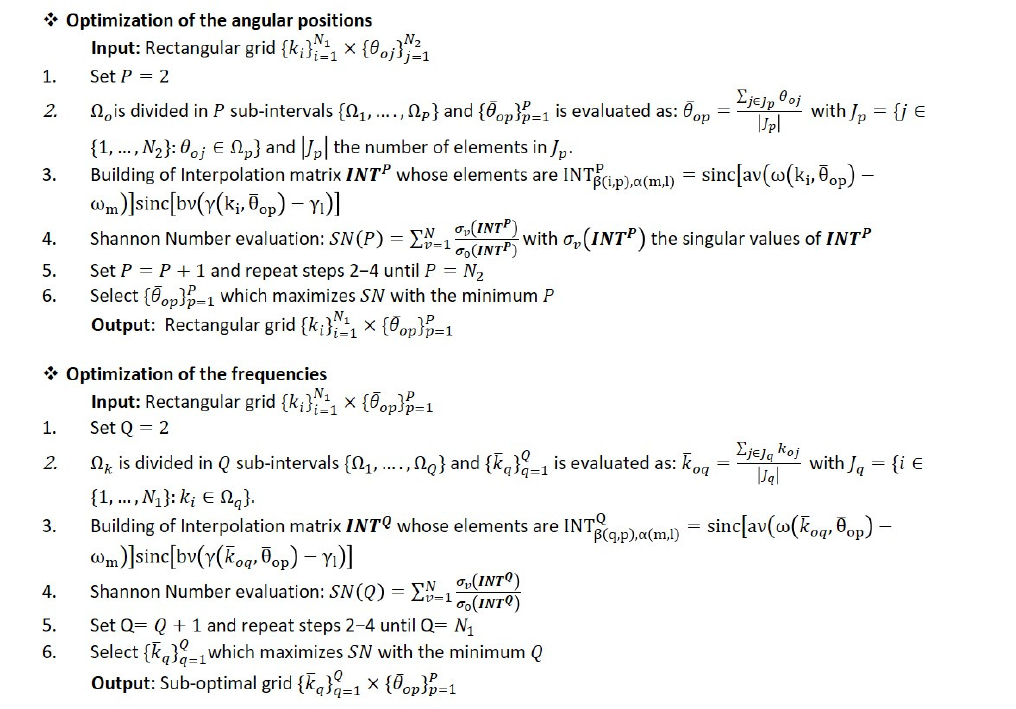
Figure 2. Suboptimal sampling